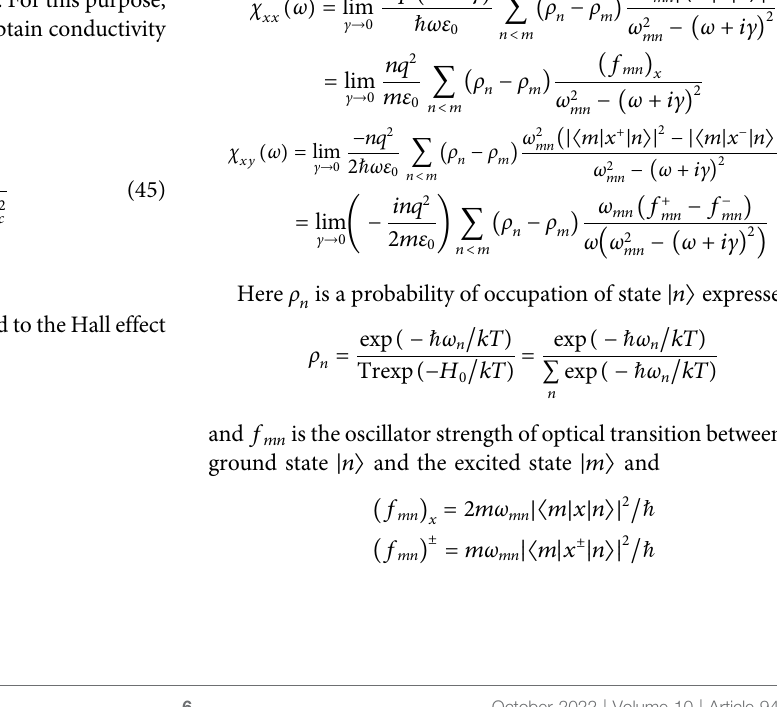
Frontiers in Physics |